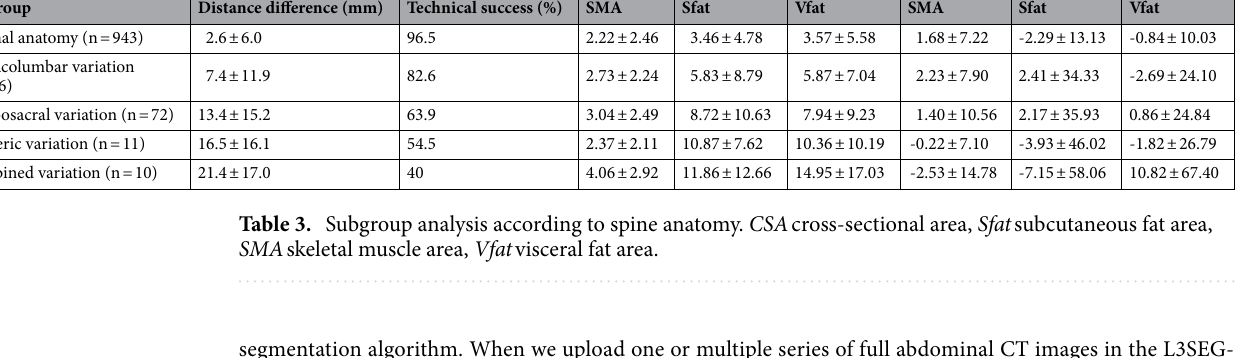
the lumbosacral junction variant subgroup and other numeric variant subgroup yielded lower technical success